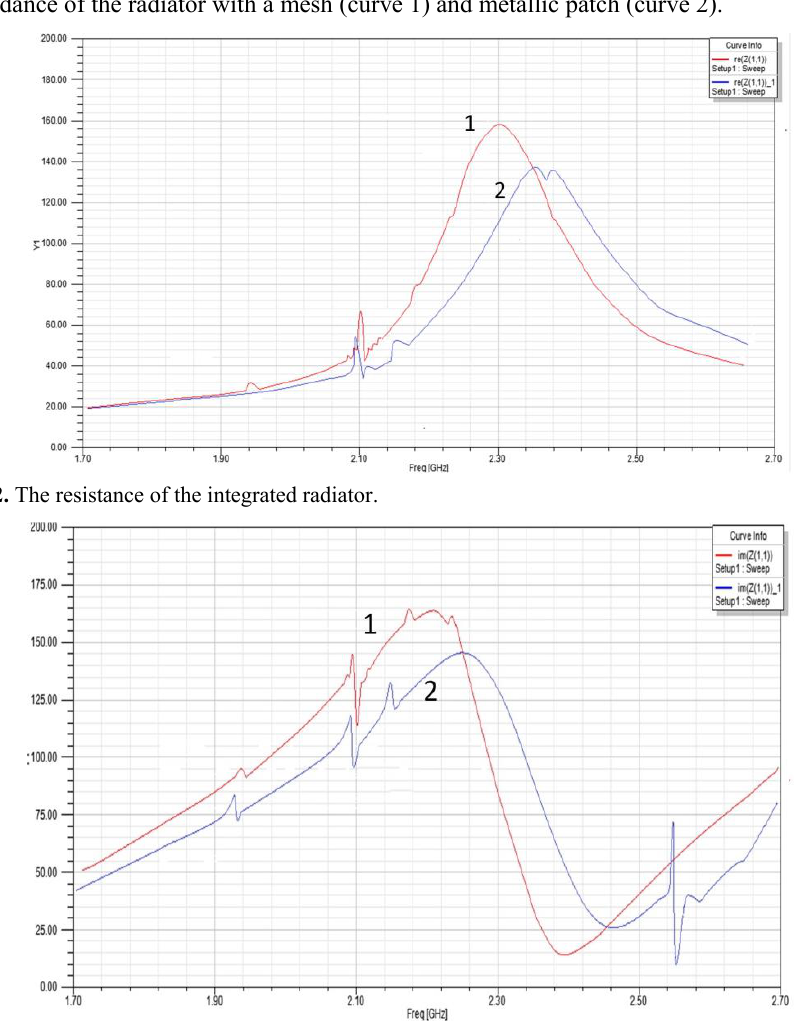
Fig. 3 . Reactance of integrated